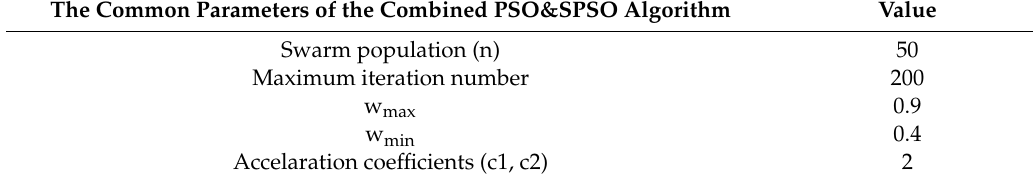
Table 3. The parameters used in the combined particle swarm optimization and selective PSO (PSO&SPSO) algorithm.